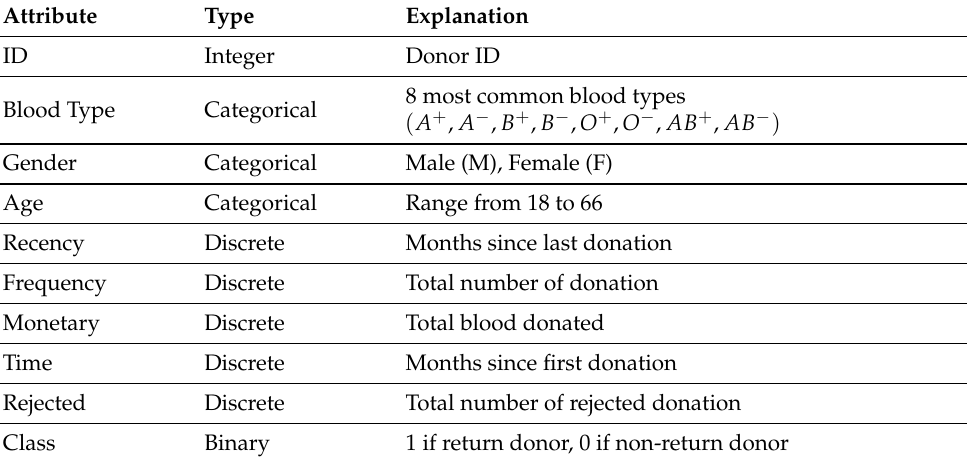
Table 2. Dataset attributes of blood donor.